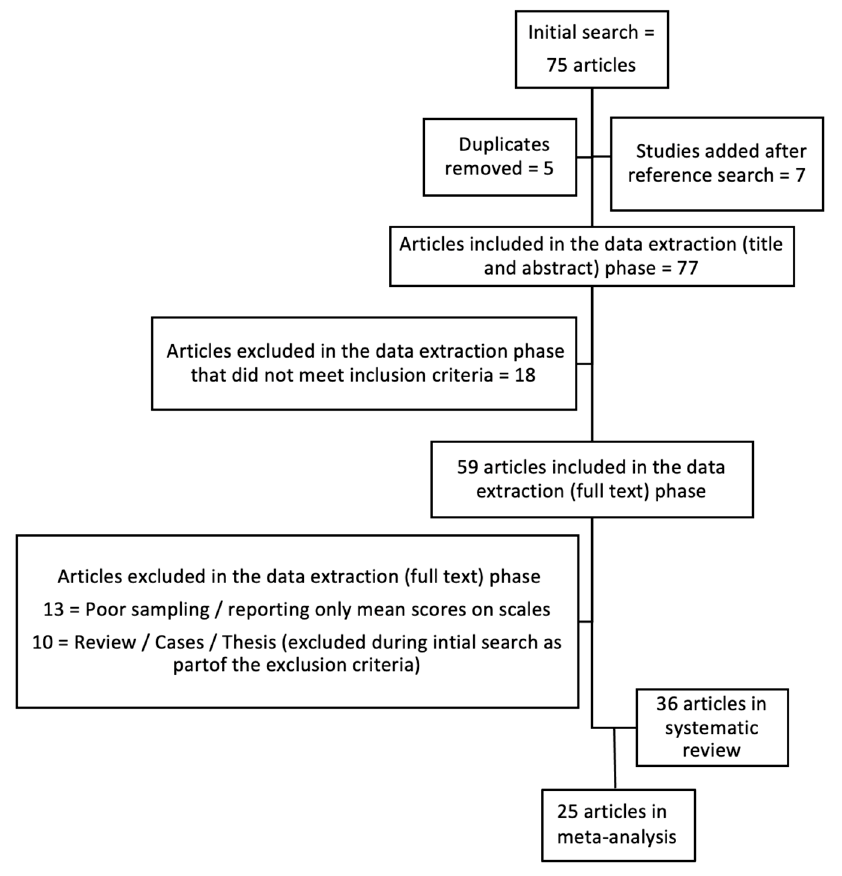
Figure 1. The PRISMA flow diagram describing the systematic review process.